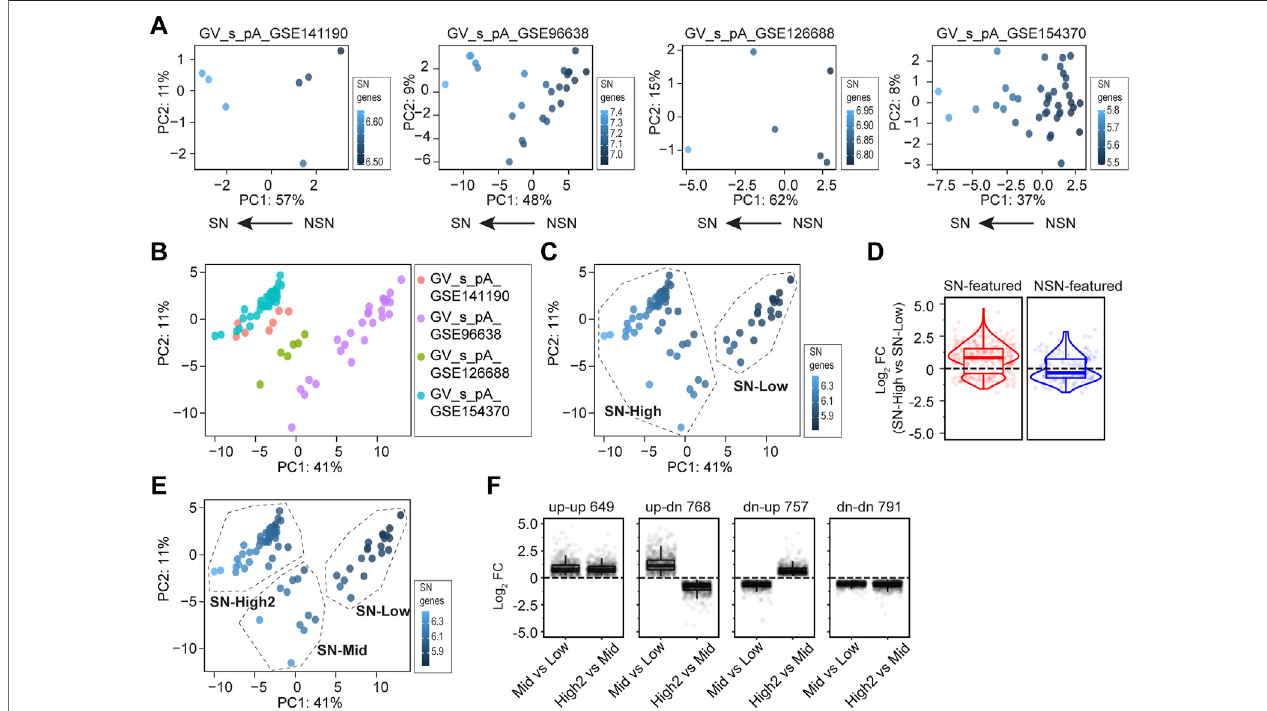
FIGURE2| Single oocyte RNA-seq provides greater insightinto GV oocytedevelopment. (A) Principalcomponentanalysesoffour singleoocyteRNA-seq (soRNA-seq) datasets. In each plot, dots are color-coded by the mean count of pre-de fi ned SN-featured genes (Ma et al., 2013). The arrows on the bottom suggest the developmental progression of all single oocytes within each dataset, identi fi ed by the level of the SN-featured genes. (B) Principal component analyses of combined datasets in (A) Dots are color-coded by the dataset identi fi ers. (C) K-means clustering based on (B) , with a pre-de fi ned cluster number of 2. Dots are color-coded by the mean counts of SN-featured genes. SN-High and SN-low are assigned based on the level of the SN-featured genes. (D) Log 2 fold change values of SN-High vs SN-Low in (C) . Each dot is a gene either SN-featured (shown in red) or NSN-featured (shown in blue). (E) K-means clustering based on B, with a pre-de fi ned cluster number of 3. SN-High2, SN-Mid and SN-low are assigned based on the level of the SN-featured genes. (F) Dot plots showing log 2 fold change values of SN-Mid vs. SN-Low, and SN-High2 vs. SN-Mid in (E) . Genes exhibit different changes from SN-Low to SN-Mid and from SN-Mid to SN-High2, including 649 genes that are up-regulated in both phases (up-up), 768 genes that are fi rstly up-regulated then down-regulated (up-dn), 757 genes that are fi rst down-regulated then up-regulated (dn-up), and 791 genes that are down-regulated in both phases (dn-dn).